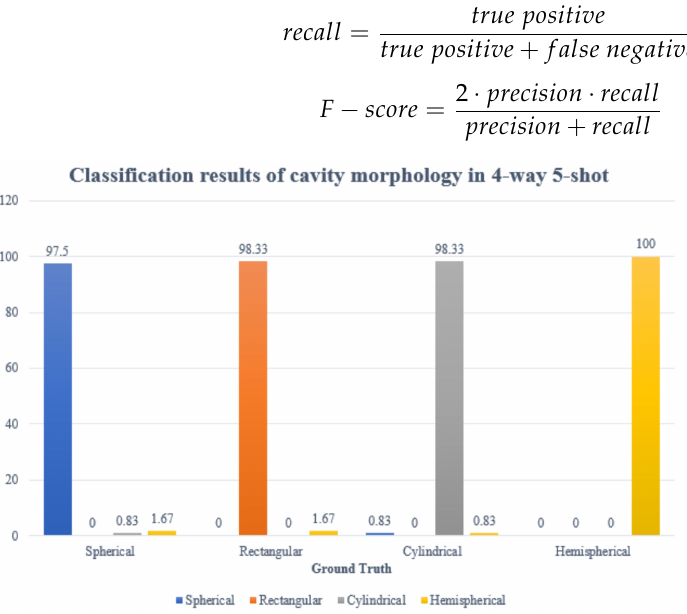
Figure 14. The results of RelationNet-based cavity morphological classification.